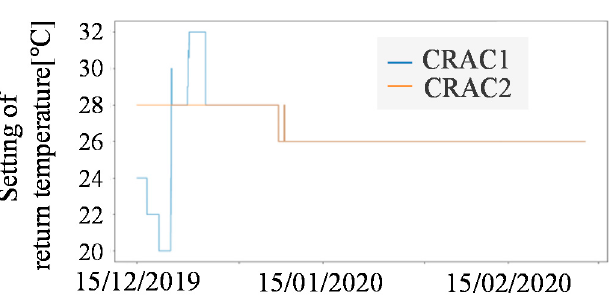
Figure 3. Status of CRAC.